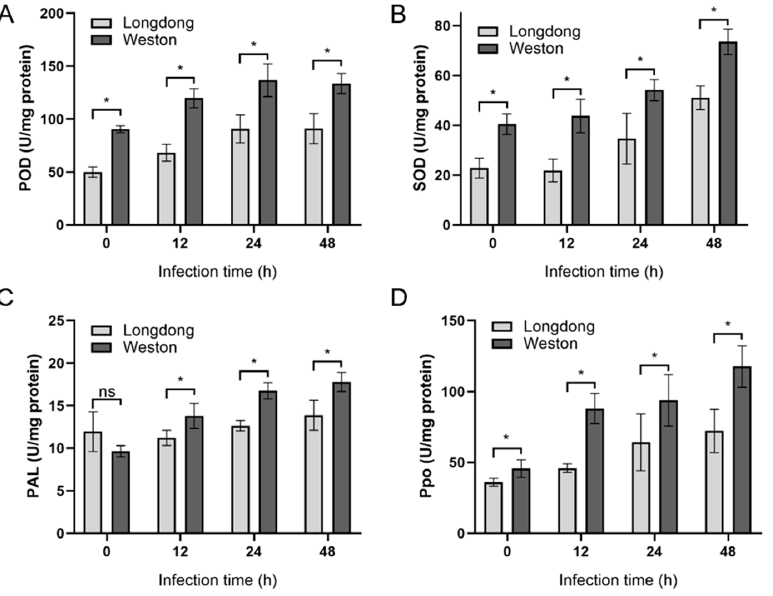
Figure 7. Antioxidant enzyme activities of resistant or susceptible alfalfa varieties infected by Phytophthora cactorum at different time points. ( A ) Peroxidase (POD), ( B ) Superoxide dismutase (SOD), ( C ) Phenylalanine ammonia-lyase (PAL), ( D ) Polyphenol oxidase (Ppo) were measured at 0, 12, 24 or 48 hpi. Data are the means of six independent experiments and error bars represent SD. Asterisks at the top of the bars indicate statistical significance (T-test, p < 0.05).